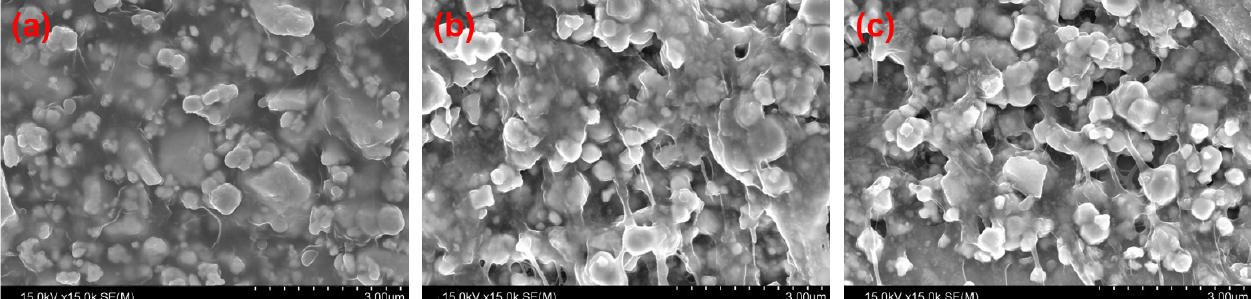
Figure 3. Cross sections of gamma-ray shielding films mixed with emulsion polymer of varying contents: ( a ) 80 wt%; ( b ) 85 wt%; and ( c ) 90 wt%.